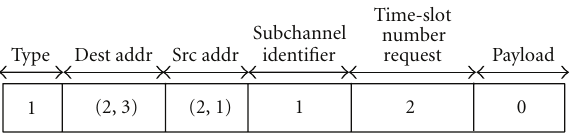
Figure 14: SDM-RDM outgoing set-up packet allocator EAST (2,1).